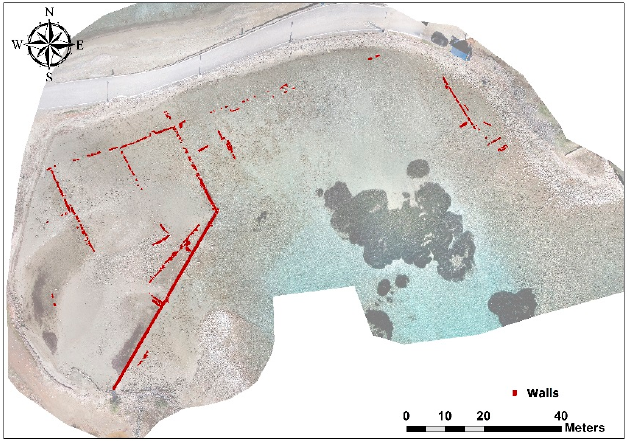
Figure 9. Orthophoto of Elounda Bay (obtained by photogrammetric processing of photographs from